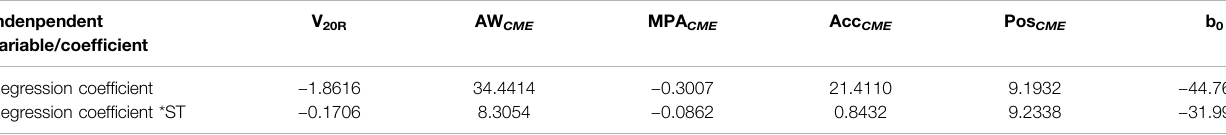
and output can be found at https://www.l3harrisgeospatial.com/ Figure 1 represents a schematic chart for the method fl ow as described above.